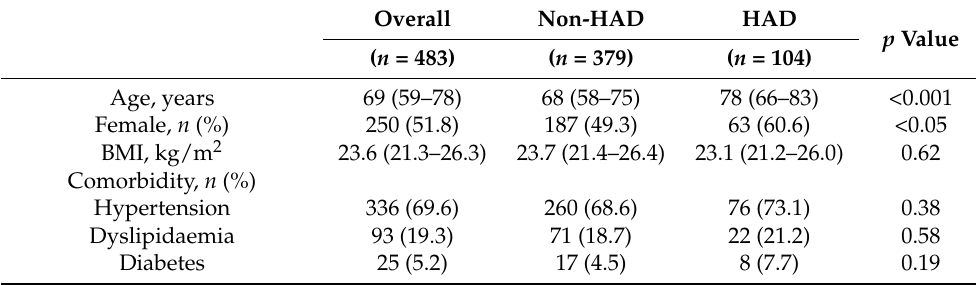
Table 1. Clinical